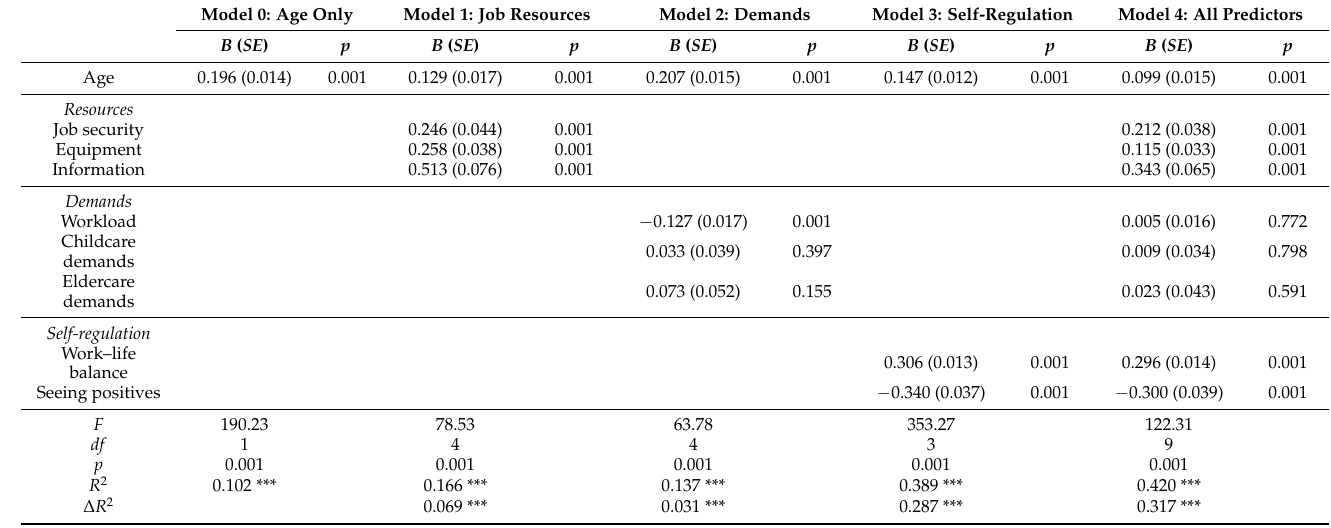
Table 3. Results of stepwise regression analysis predicting resilience ( N =